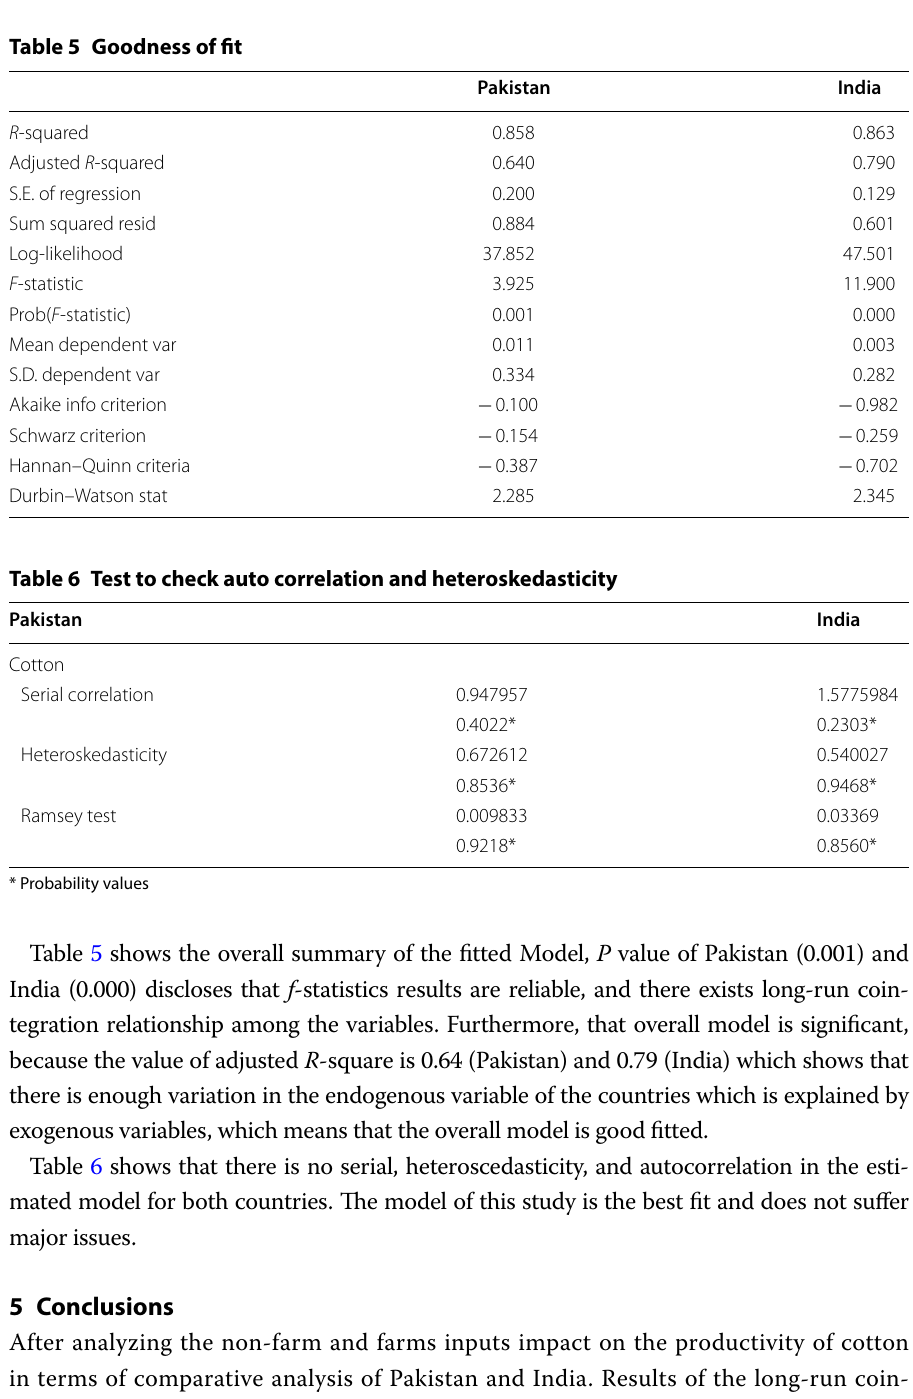
Table 5 Goodness of fit